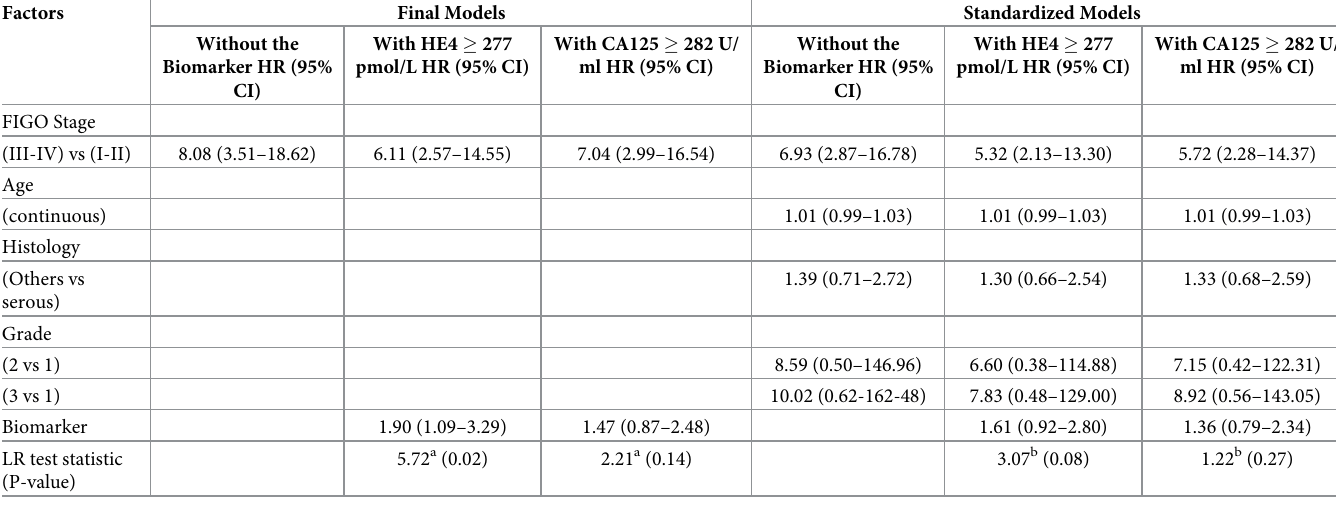
Table 4. Adjusted hazard ratios (HR) of death and their 95% confidence interval (CI) associated with preoperative plasma HE4 and CA125 in women with epithelial ovarian cancer (N = 177).